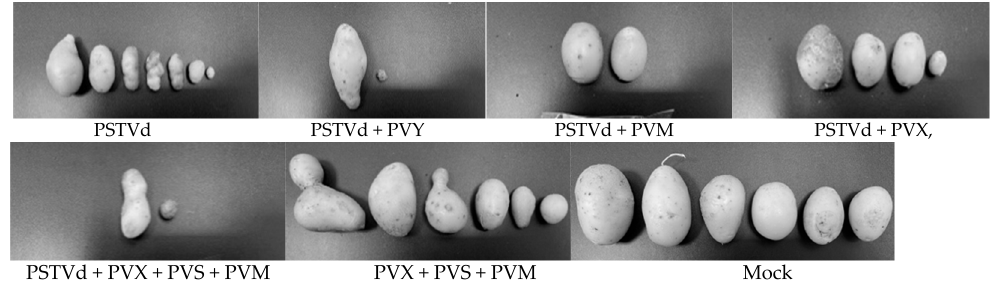
Figure 11. Tubers of cv. Navigator at 90 dpi with PSTVd and viral/viroid mixed infection.